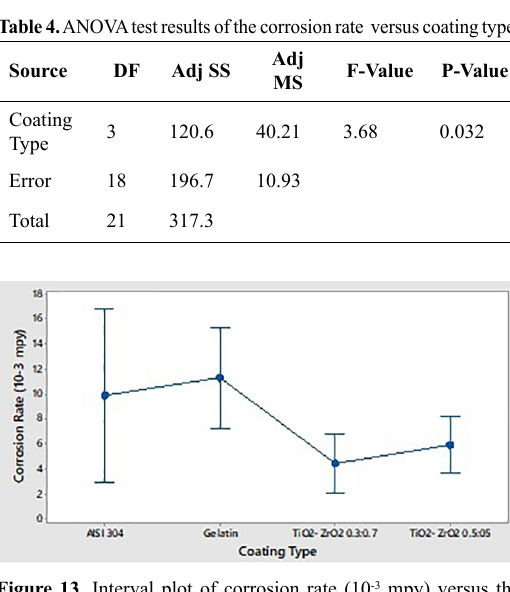
Figure 13. Interval plot of corrosion rate (10 -3 mpy) versus the coating type.